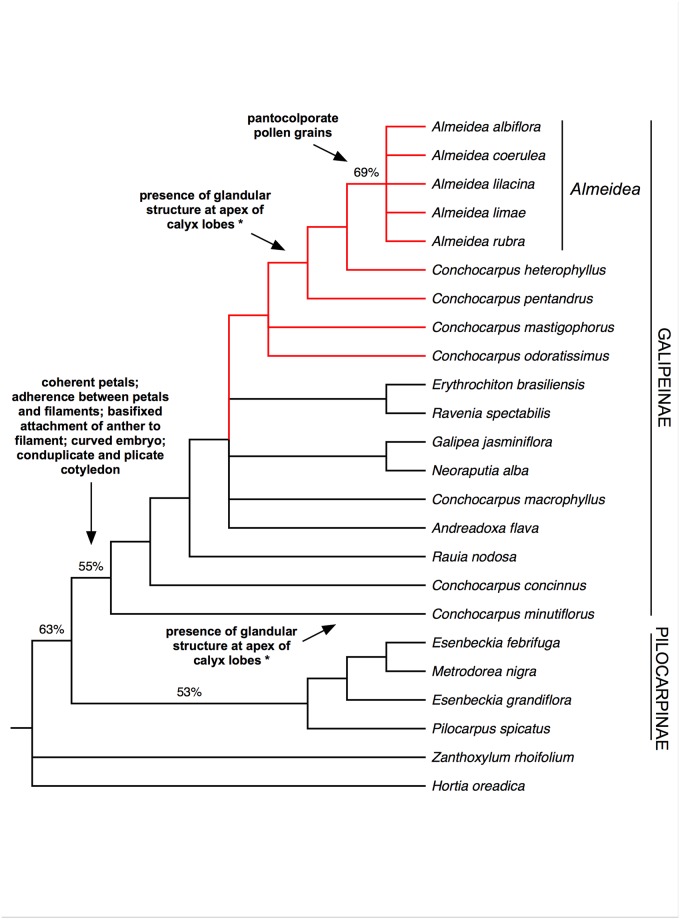
Majority-rule consensus tree of 270 equally parsimonious trees resulting from analysis of morphological data of the Galipeinae and outgroups.Support for branches is given by parsimony bootstrap percentages (≥ 50%). Possible morphological synapomorphies are indicated in the clades; * indicates possible homoplasy.